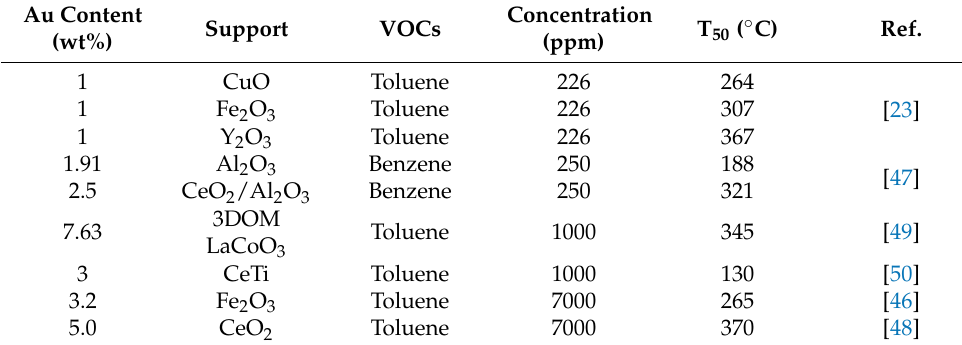
Table 2. Support types used with the Au active site for VOC